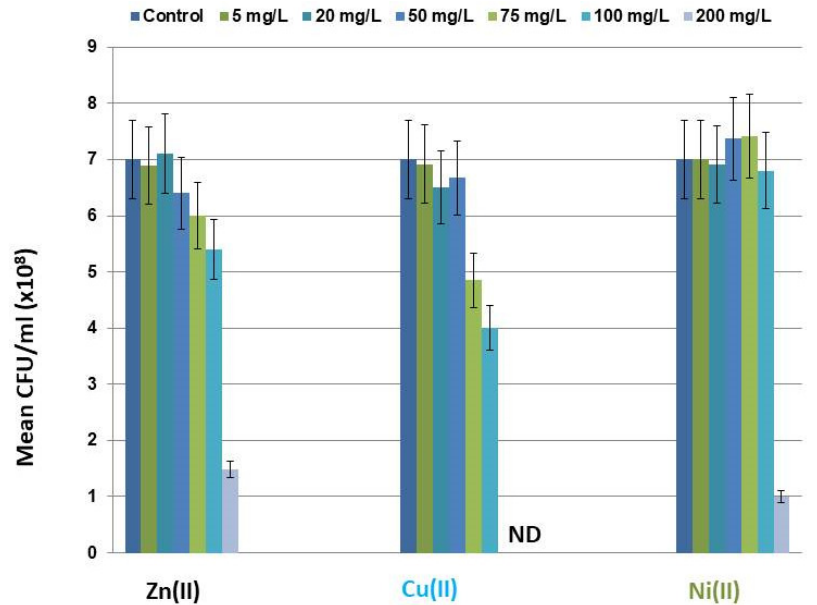
Figure 1. The dose-dependent impact of zinc, copper, and nickel on the S. xiamenensis DCB2-1 cell population is presented as CFU/mL. The data presented are the mean values ± SD from three separate sets of experiments.